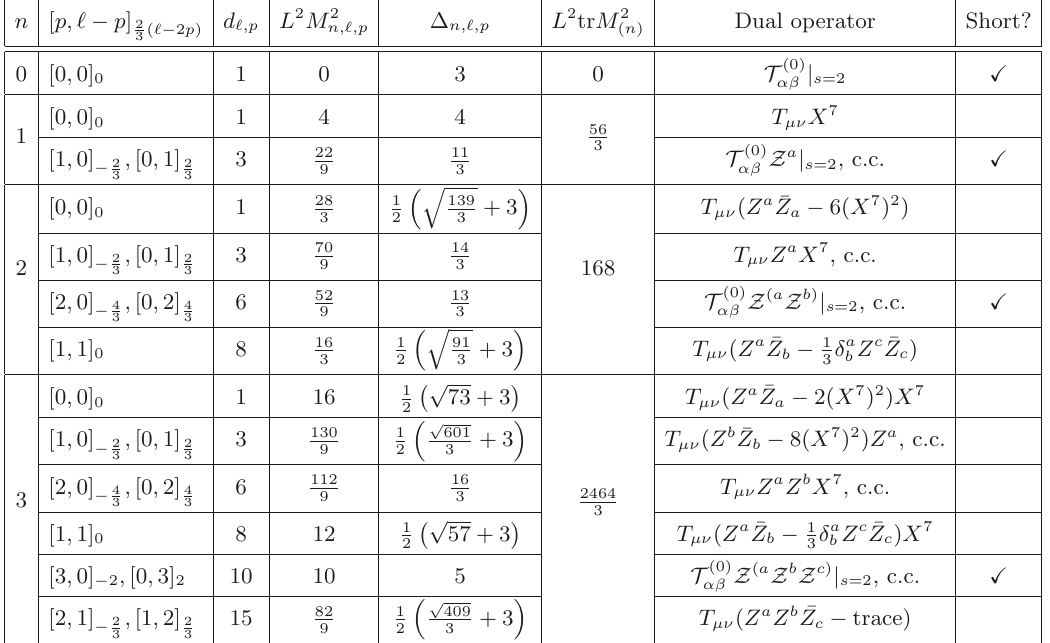
= 2 SU(3) U(1)-invariant solution [7] of massive N × U(1) charges (2.45), degeneracy (2.36), ×